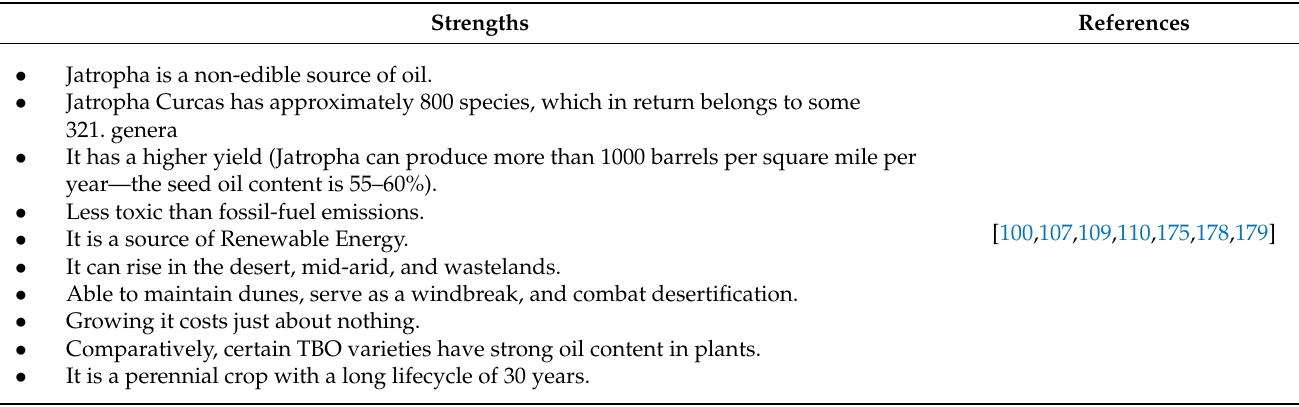
Table 14. Strengths, weaknesses, opportunities, and threats analysis for the production of biodiesel from Jatropha.